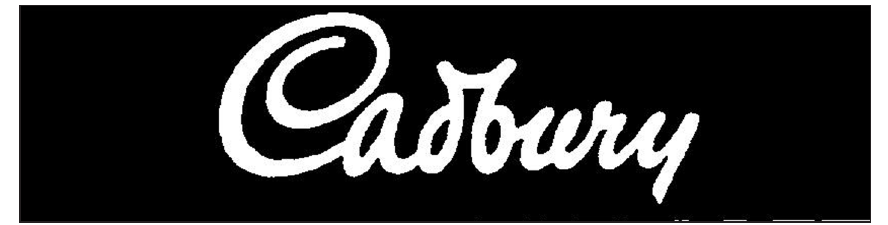
Figure 1: Cadbury UK Limited 2000, Cadbury [image mark], Trade Mark no EU 001367515 © Cadbury UK Limited